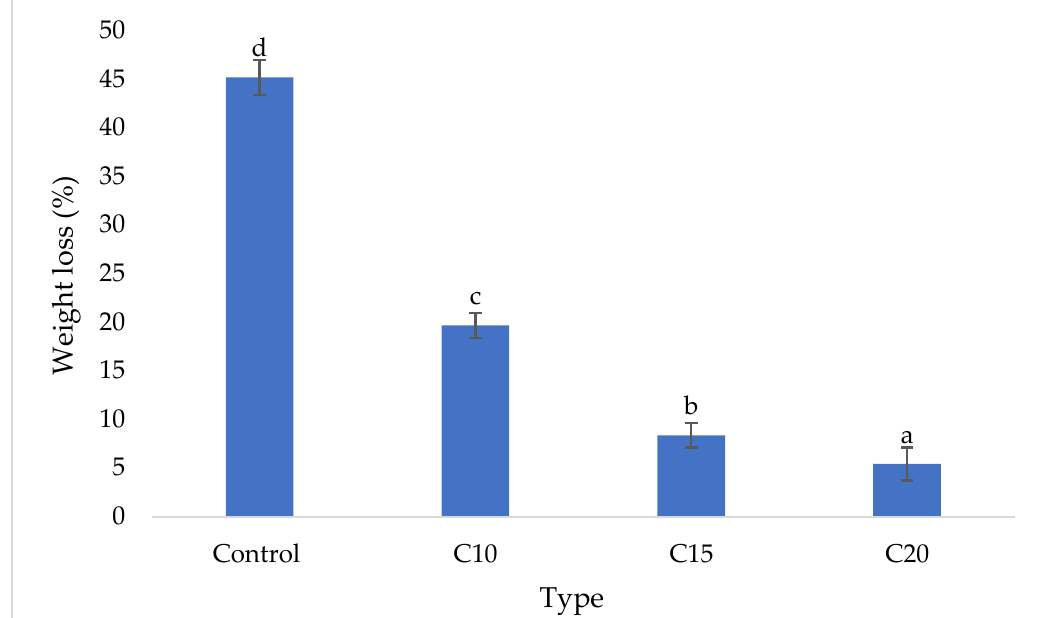
Figure 4. Weight loss of particleboard samples after 4-week exposure to Pycnoporus sanguineus. Note: Means followed by the different letters a, b, c and d are significantly different at p ≤ 0.05. CA10 = 10 wt% citric acid, CA15 = 15 wt% citric acid, CA20 = 20 wt% citric acid.